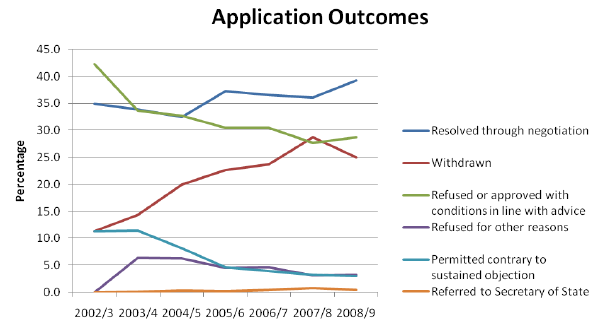
Fig. 4. The outcomes of applications (from Environment Agency Figure 4. The outcomes of applications (from Environment Agency High Level Targets 5 and High Level Targets 5 and